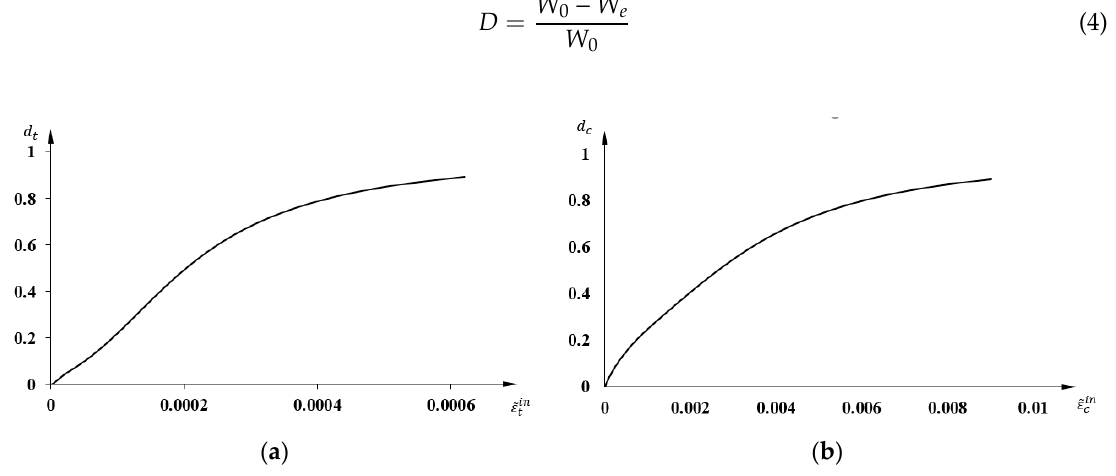
Figure 3. ( a ) Relationship between tensile damage and inelastic strain; ( b ) relationship between compressive damage and inelastic strain.